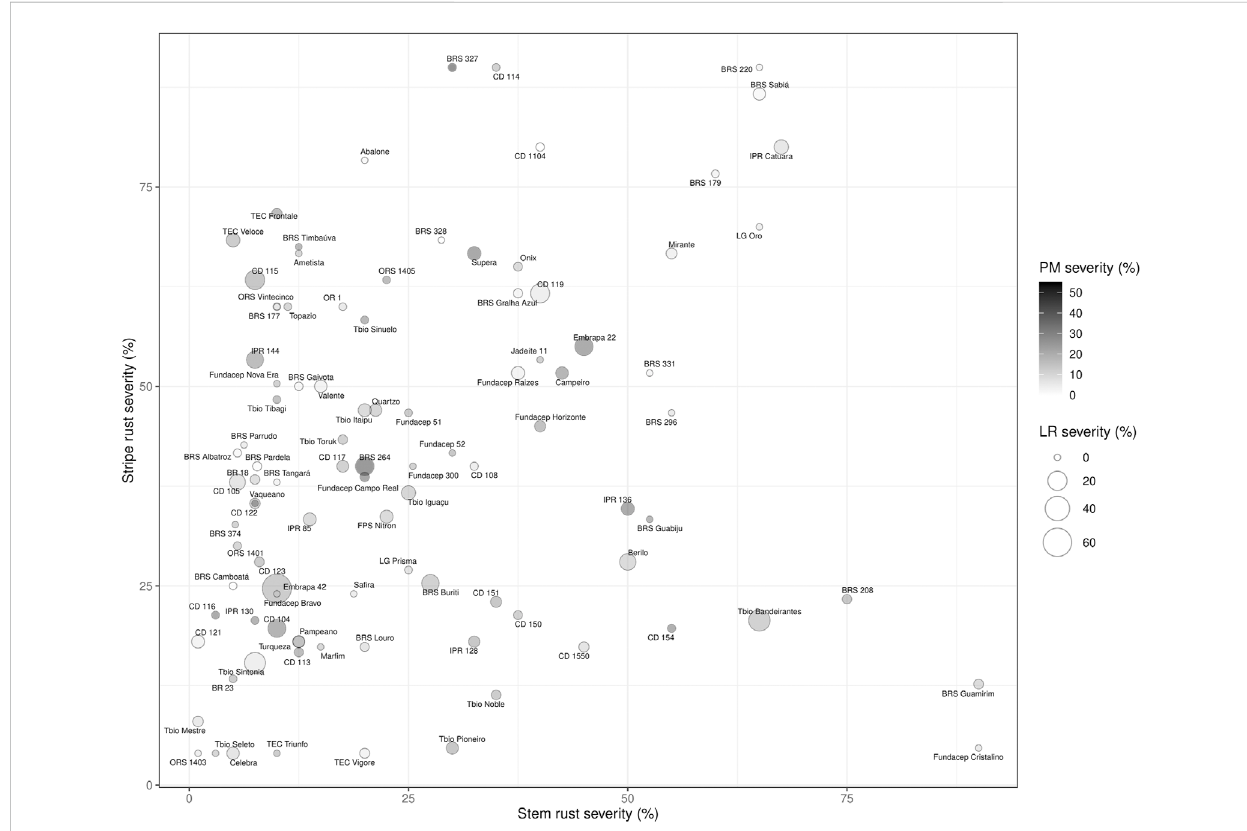
FIGURE 2 Chart representing the average reaction of the Brazilian cultivars to leaf rust (bubble size), stripe rust (y-axis), stem rust (x-axis) and powdery mildew (color intensity) in fi eld nurseries in